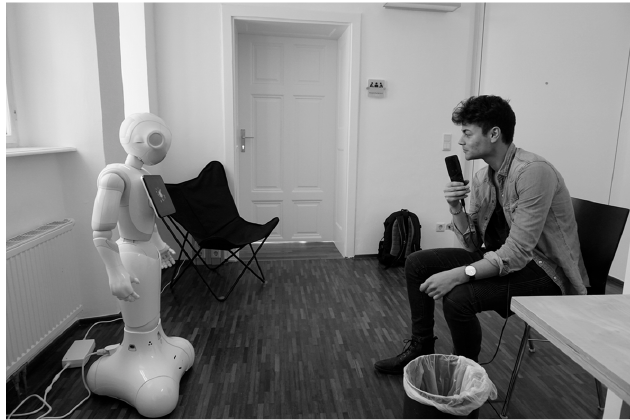
Figure 3. Robot Pepper in the experimental setting at the “Young Architects” experiment, at Vienna University of Technology. The questioned objects in this picture are: robot, chair, backpack and waste bin; a lamp is not visible.